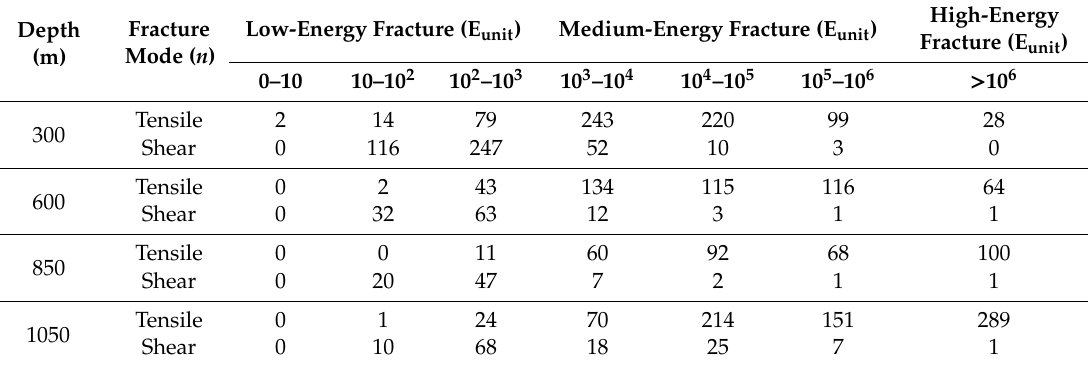
Table 3. Statistics of tensile and shear fractures with di ff erent AE energy value inside coal samples at di ff erent